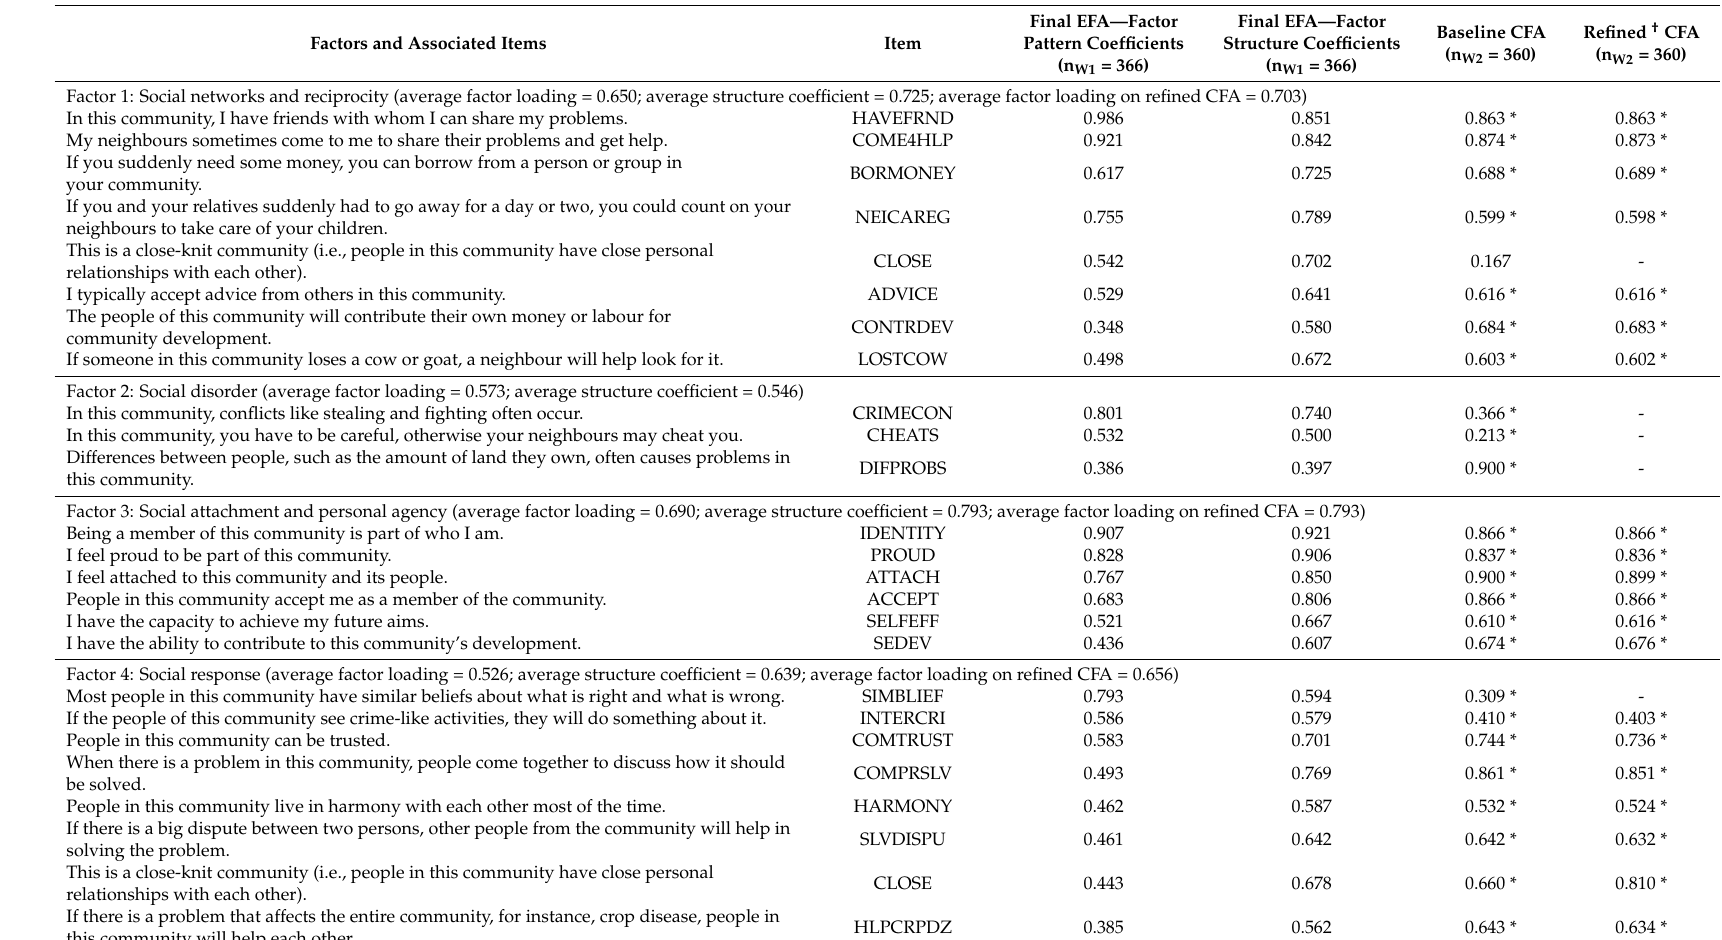
Table 4. Factor loadings for random split-half samples for EFA and CFA of EFA-derived factor solutions, women. Factors and Associated